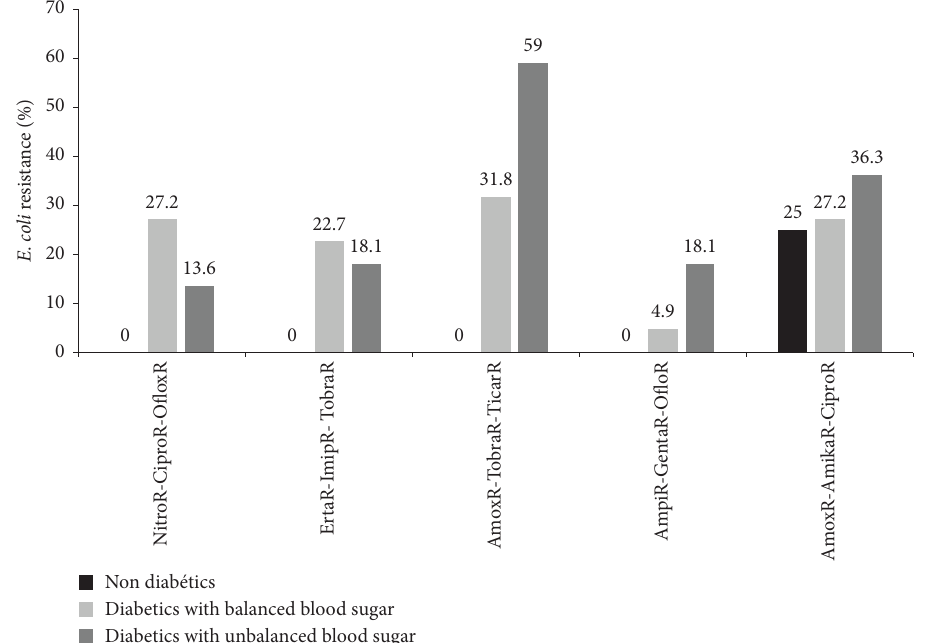
Figure 4: Distribution of E. coli resistance to triple antibiotics as a function of diabetic status. Amika: amikacin, Amox: amoxicillin, Ampi: ampicillin, Cipro: ciprofoxacin, Erta: ertapenem, Genta: gentamicin, Ofox: ofoxacin, Ticar: ticarcillin, Tobra: tobramicin, Imip: imipenem, and Nitro: nitrofurantoin.